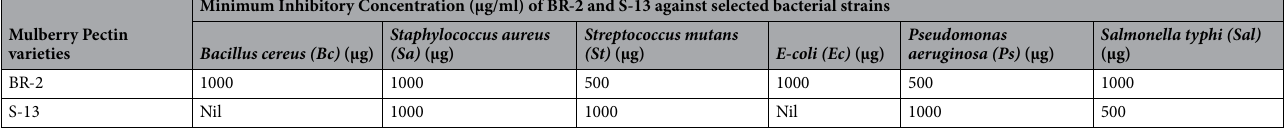
Mulberry Pectin varieties